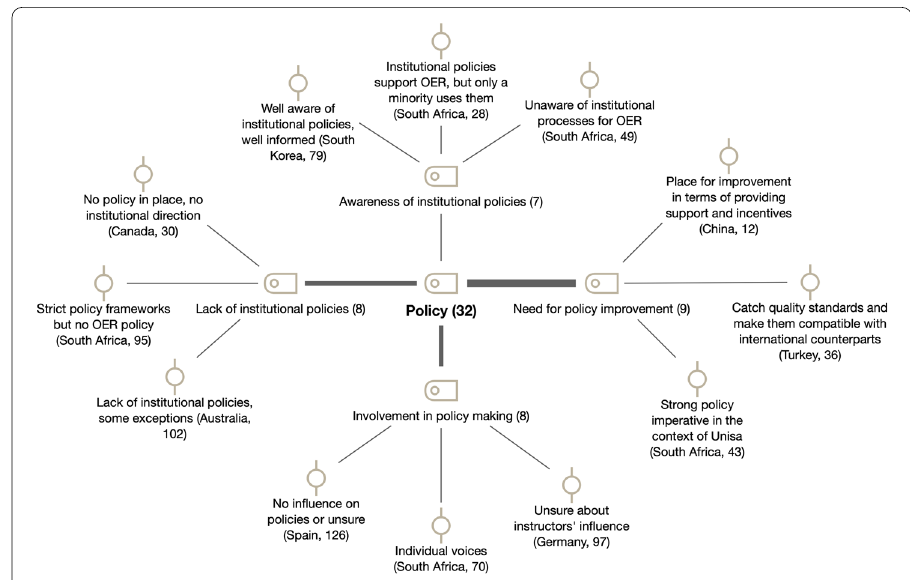
Fig. 7 Subcodes and examples for policy